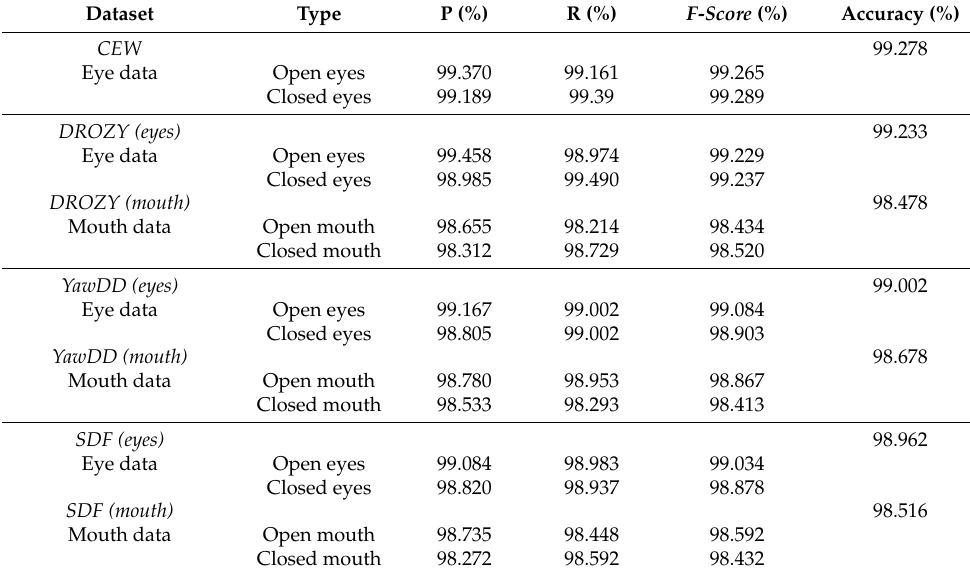
Table 4. Classification results of the RCAN in each